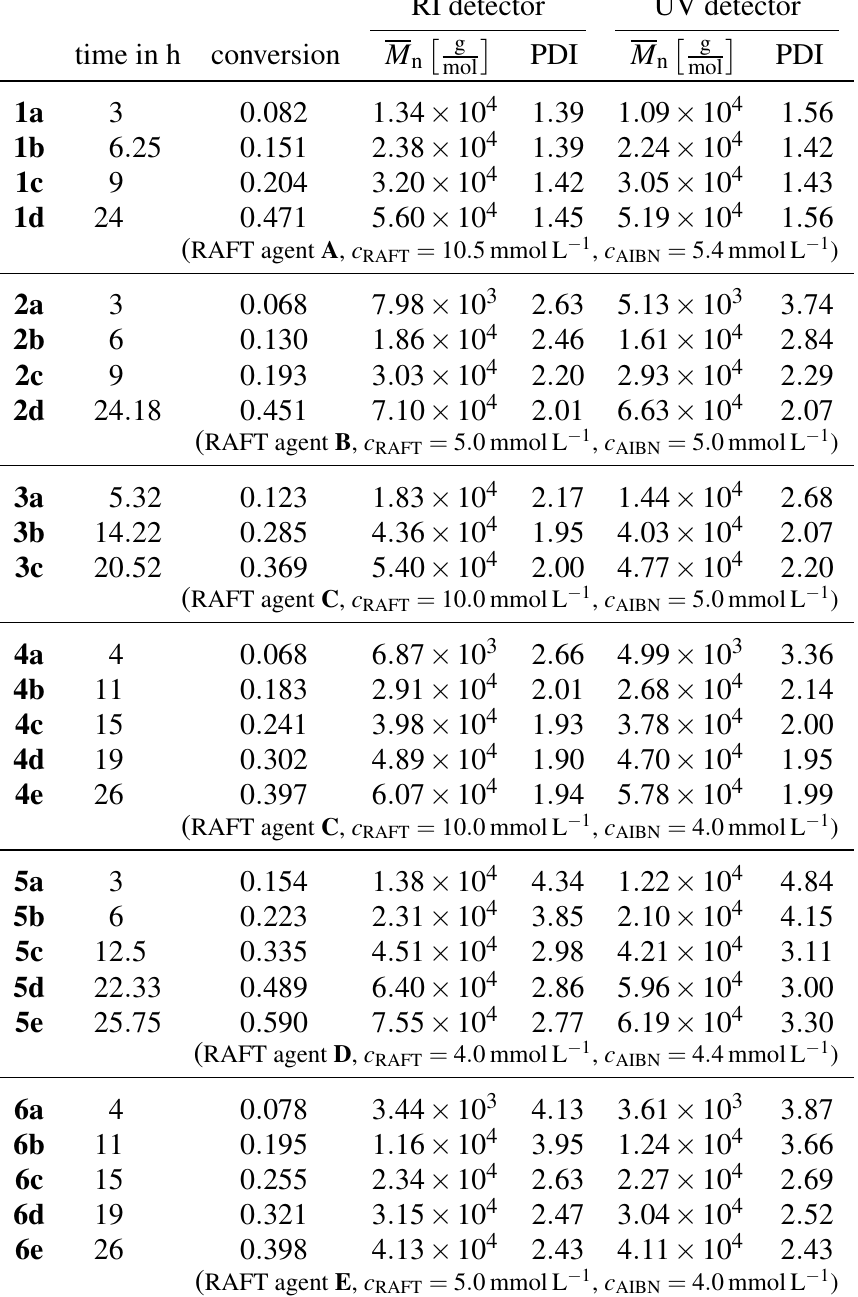
Table 2. Bulk polymerizations of styrene with different polyfunctional RAFT agents at 60 ◦ C and ambient pressure using AIBN as initiator. The table lists the individual experimental conditions, the gravimetrically determined monomer conversions of the samples, and the corresponding M and polydispersity indices (PDI) obtained by the RI and the UV n